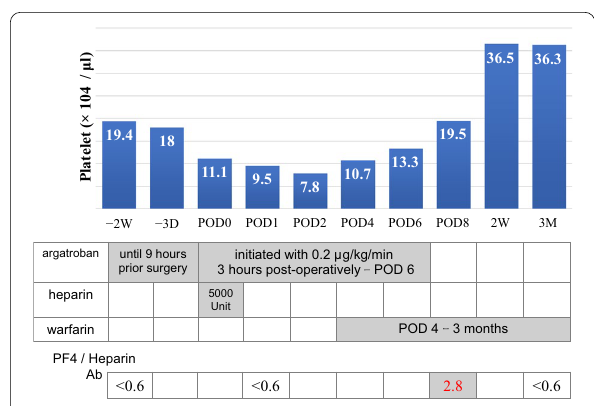
Fig. 2 Course of platelet count, anticoagulation therapy, and PF4/H antibody . Platelet count reduced to 7.8 10 4 /μl on POD 2 and × recovered gradually. Argatroban was initiated 3 h postoperatively and continued until POD 6. Warfarin was also started when platelet count exceeded 10 10 4 /μl on POD 4 and continued for 3 months. PF4/H × Ab turned positive on POD 8, but disappeared 91 days later. POD, postoperative day; PF4/H Ab, platelet factor-4/heparin